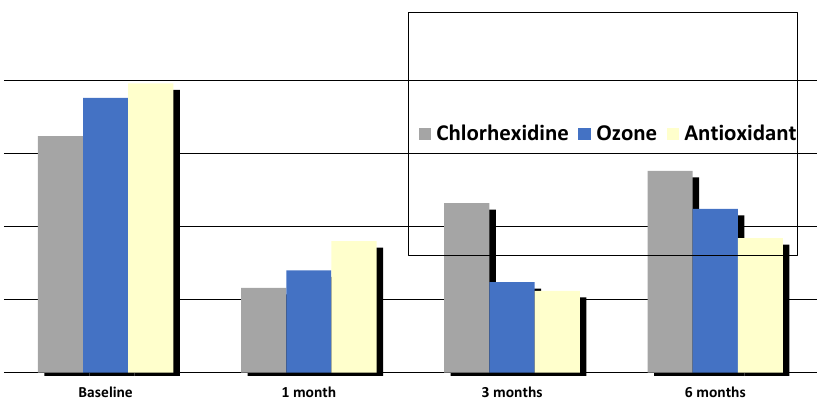
Figure 2. The BoP values decreased for all groups evaluated et each time point, with significant reductions after 1 and 3 months (T1 and T2), values are reported in Table 2.